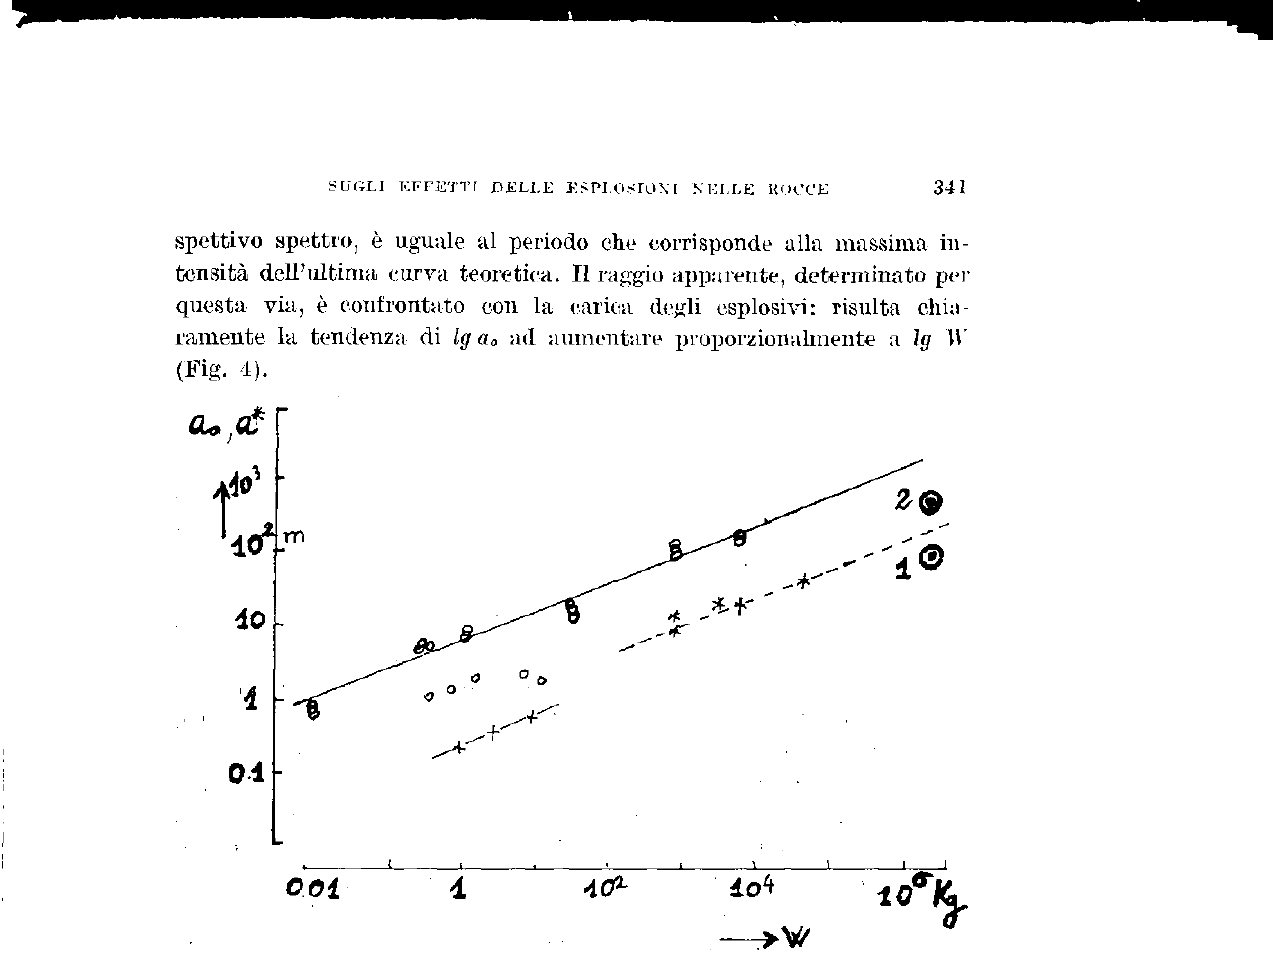
Fig. 4 - Eaggio apparente per onde elastiche d'origine esplosiva (°), raggio equivalente delle zone frantumate (*) in funzione della carica esplosiva, secondo Kasaliara; —x — X-— relazione fra W e a*, secondo gli esperimenti di T. Murata; © stessa relazione nel caso di esplosioni nucleari: di Hardhat (1 ) e di Salinoli